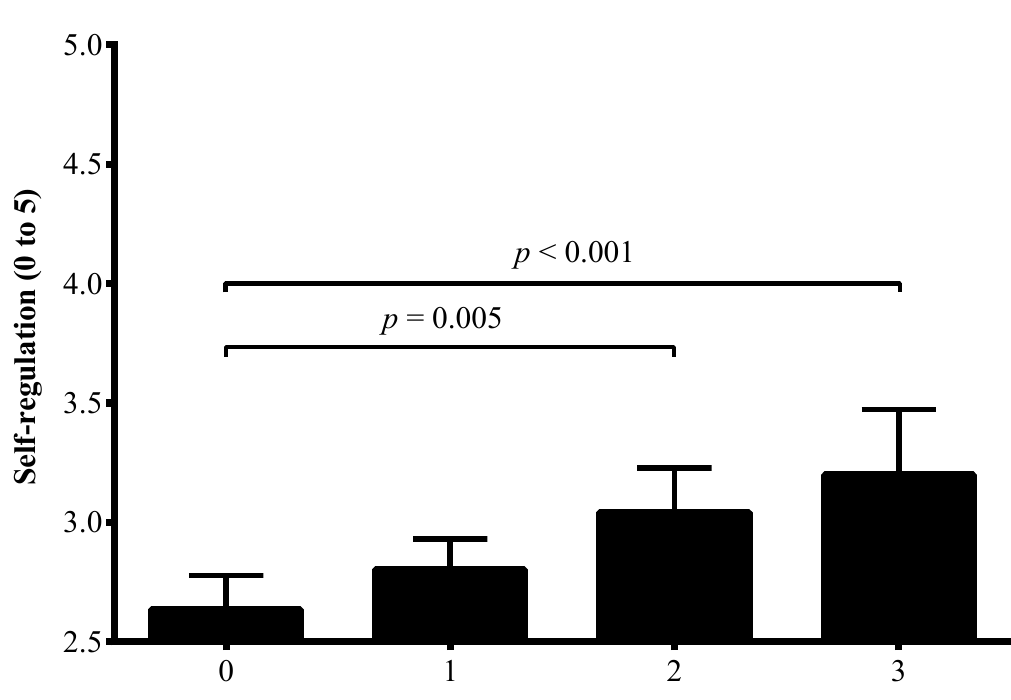
Figure 1. Differences in mean values of self-regulation according to the number of healthy lifestyle habits that children met.